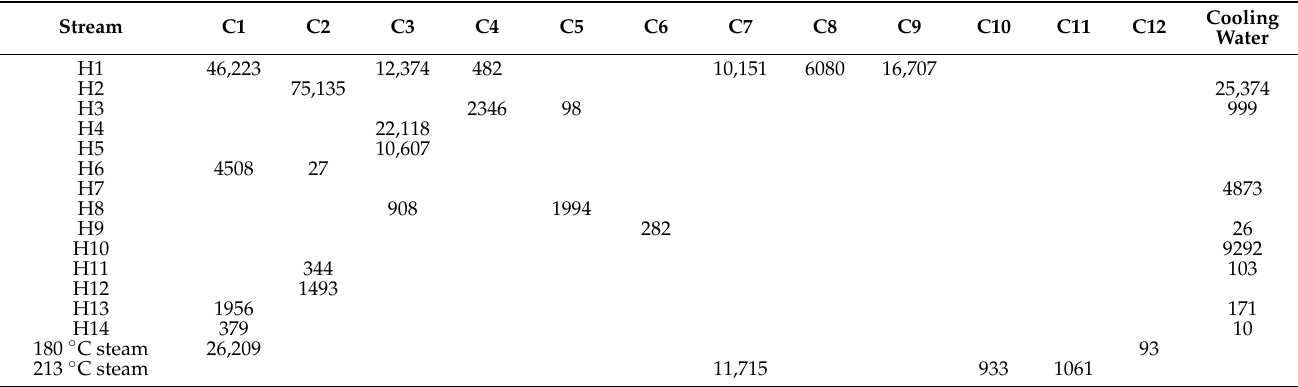
Table 5. Optimized HEN of the EG